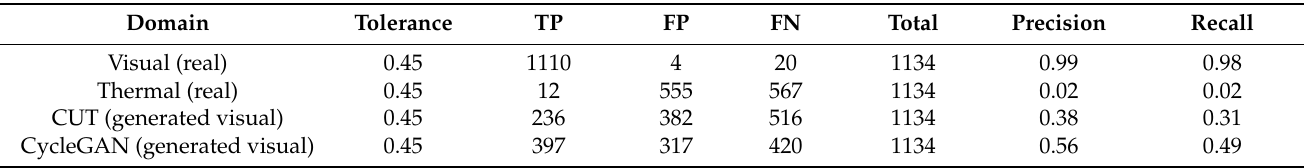
Table 5. The results of the face recognition model. TP—the number of true positives. FP—the number of false positives. FN—the number of false